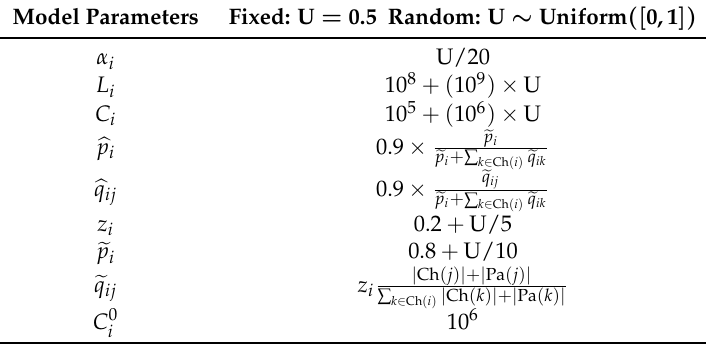
Table 1. Internet Games’ Model Parameters.